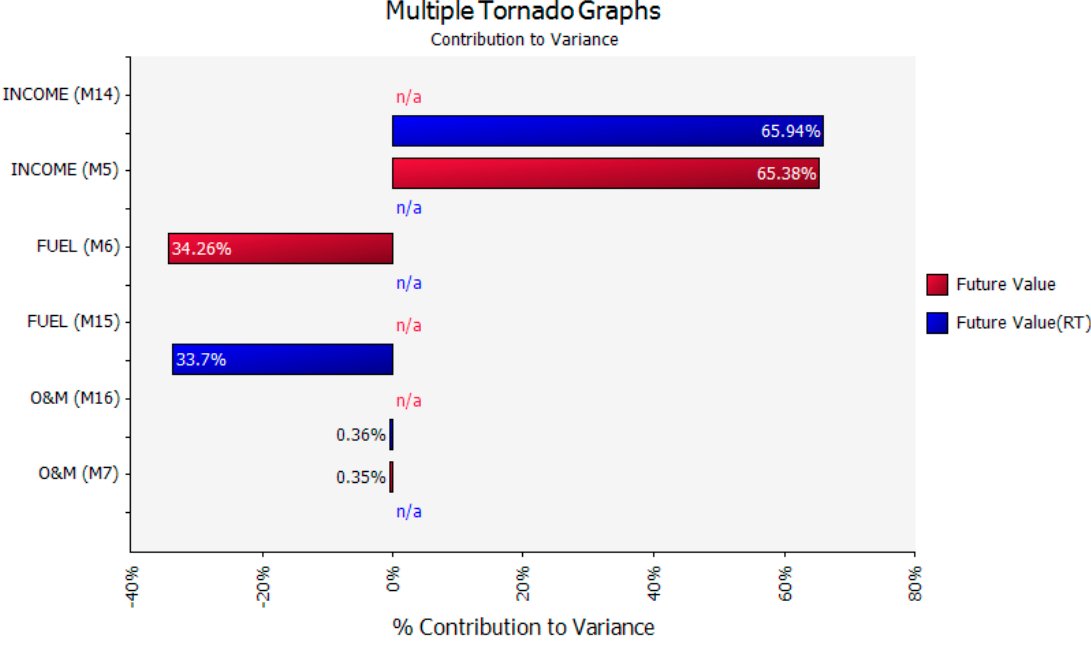
Figure 10. Sensitivity analysis on A-USC (red) & A-USC with RT (blue).